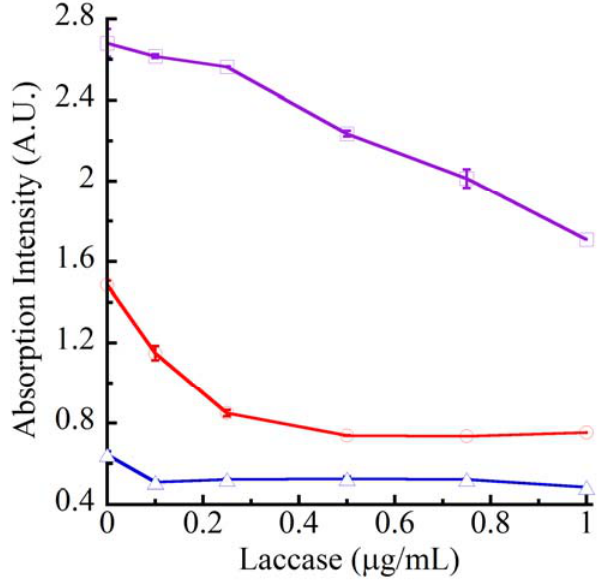
Figure 1A. Laccase dose-response profiles for CA oxidation monitored by 260 nm absorption. Increasing concentrations of laccase were used to oxidize 500  M CA in 100  L of pH 4.5 buffer under real-time kinetic measurements using UV-transparent 96-well microplate. Decreases in CA absorbance were measured at 20 min for the samples purchased from Alfa Aesar (open triangles, blue tracing), Acros Organics (open circles, red tracing) and Sigma-Aldrich (open squares, purple